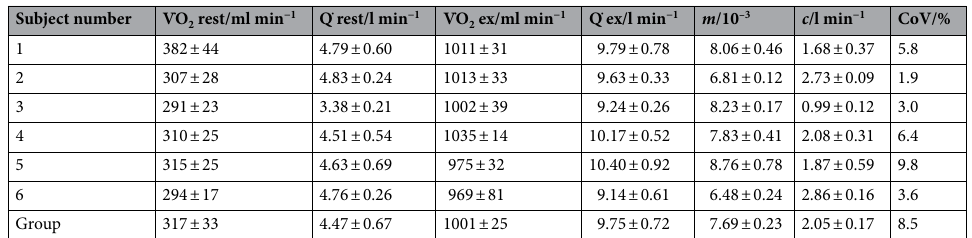
Table 1. For each participant, the measured oxygen consumptions (V ̇ o 2 ) and determined cardiac outputs (Q ̇ ) at rest and exercise are given (mean ± SD). The gradient ( m ) and offset ( c ) of linear fits to each participant’s data are shown (mean ± SE), with the coefficient of variation (CoV) stated in each case. The parameters shown for the group, including CoV, describe a linear regression to all 57 data points. The overall CoV (within subject, between day) for this technology was found to be